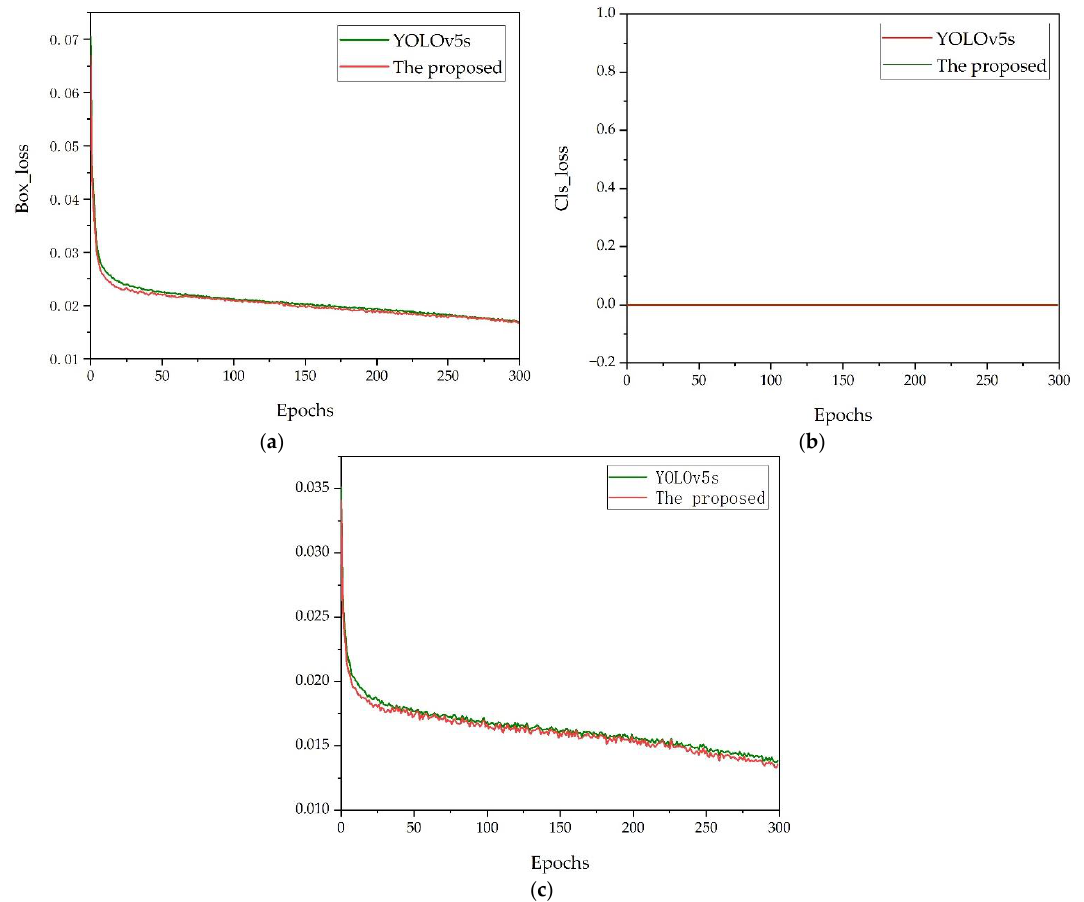
Figure 6. Training loss comparison. ( a ) Bounding box location loss, ( b ) classification loss, ( c ) confi- dence loss.